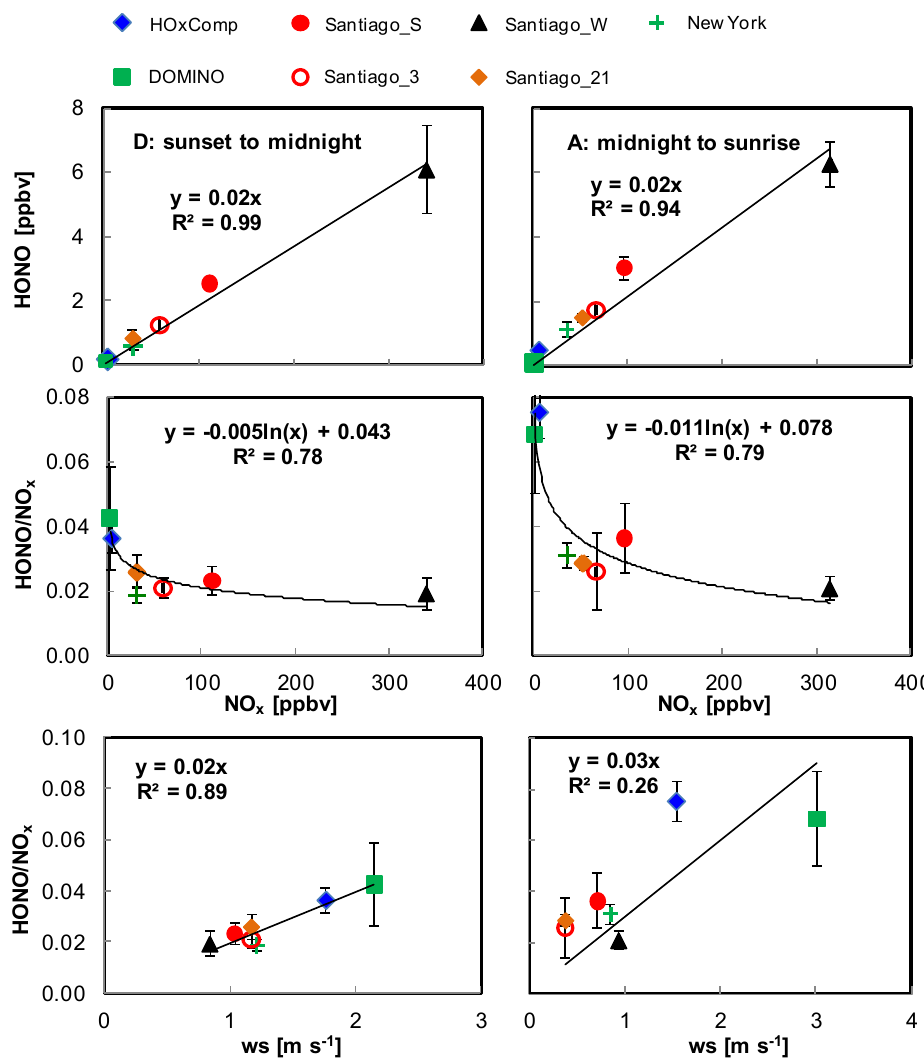
Fig. 4. Correlation of nighttime average HONO and NO x mixing ratios as well as wind speed (ws) for sector A (right panel, from midnight to sunrise) and sector D (left panel, from sunset to midnight). Error bars represent 1 σ of the mean.